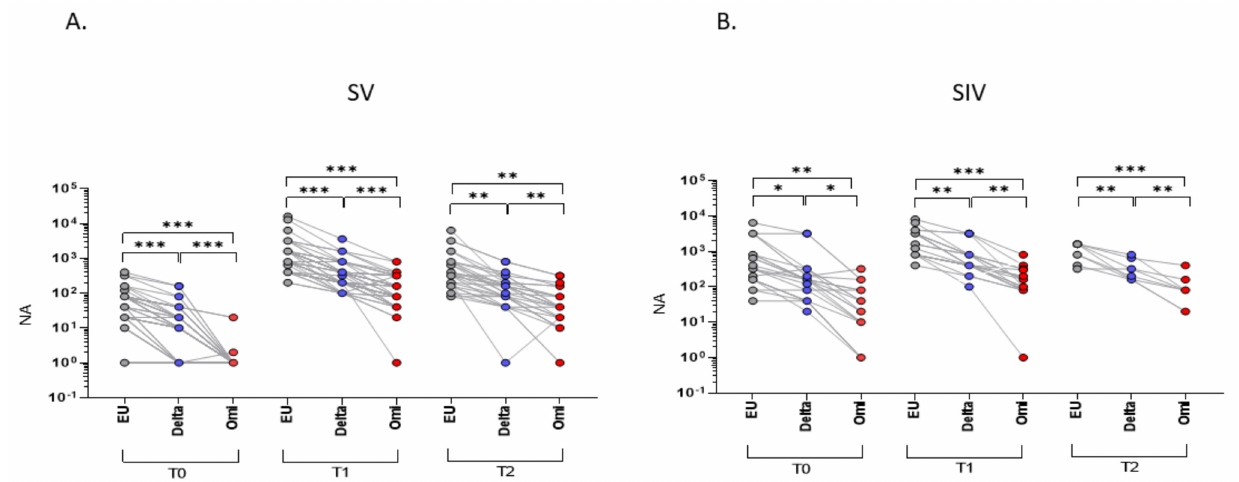
Figure 1. Plasma neutralizing activity (NA) correlations among different VOCs. NA correlation performed at different time points (T0, T1, and T2) showed a higher activity against the EU variant compared to the Delta and Omicron (Omi) ones in plasma samples from both SARS-CoV-2 Vaccinated subjects (SV) ( A ) and SARS-CoV-2 Infected and Vaccinated subjects (SIV) ( B ). Lines connect the NA of each subject. * p < 0.05, ** p < 0.01, *** p < 0.001.